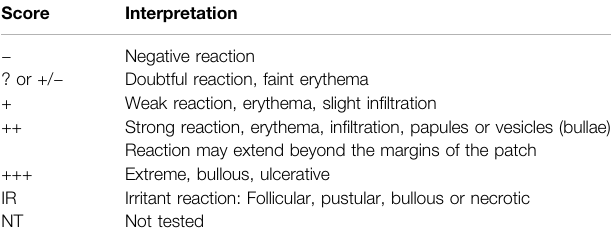
TABLE 2 | Score — Interpretation of patch testing